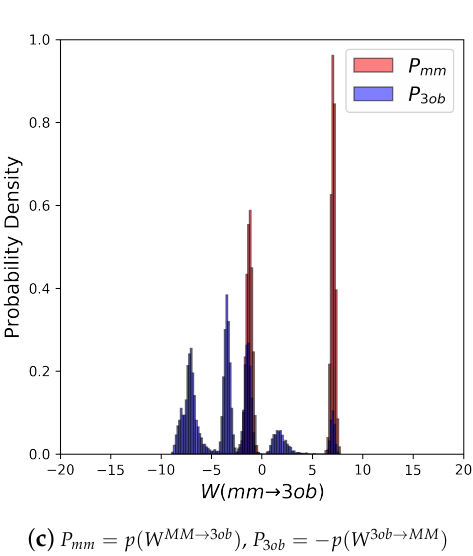
Figure 10. ( a ) Molecule 8 ’s potential energy “forward” ( P mm ) and “backward” ( P 3 ob ) distributions plotted as “offset” from the ∆ U MM → 3 ob to simplify the x-axis. ( b ) Molecule 8 ’s nonequilibrium work “forward” ( P mm ) and “backward” ( P 3 ob ) distributions from 1 ps switching simulations plotted as “offset” from the W MM → 3 ob to simplify the x-axis. ( c ) Molecule 8 ’s nonequilibrium work “forward” ( P mm ) and “backward” ( P 3 ob ) distributions from 5 ps switching simulations plotted as “offset” from the W MM → 3 ob to simplify the